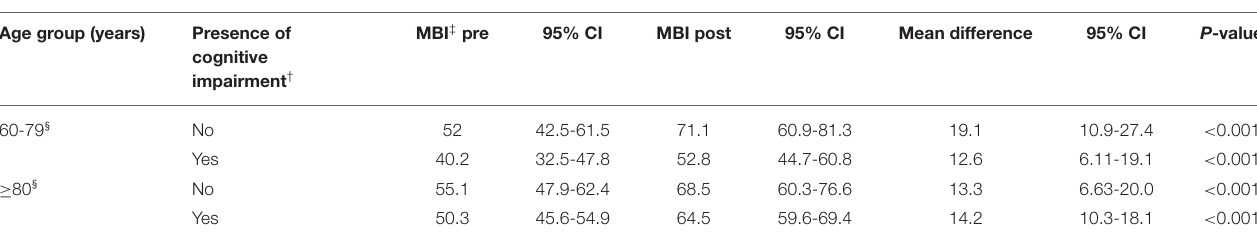
TABLE 3 | Age and cognition in predicting functional